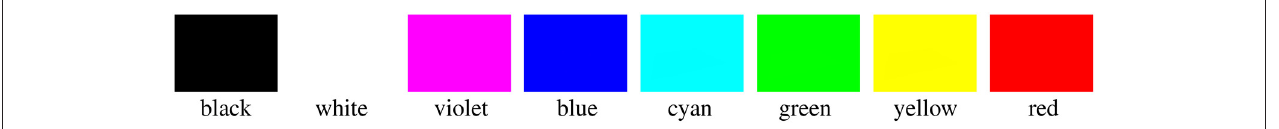
FIGURE 1 | Selection of colors that can be applied to the background and ranges of the plotted matrix.